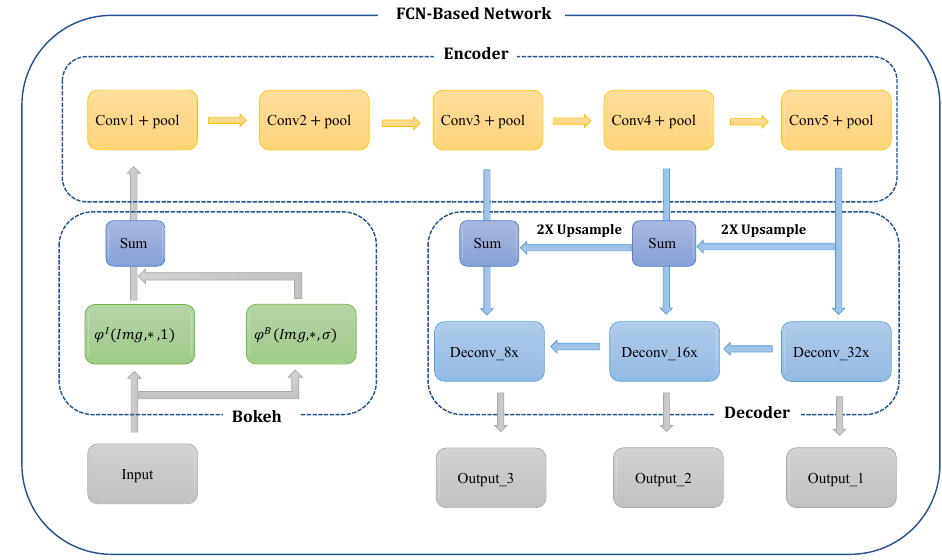
Figure 5. The FCN [9] network architecture after adding bokeh is illustrated in the figure above. The entire network can be subdivided into bokeh, encoder and decoder. Bokeh is described in Section 3. The encoder is composed of 5 “ConvX + pool” downsampling blocks. The value of “*” is GT (ground truth) in the training stage and CP (coarse prediction) in the verification